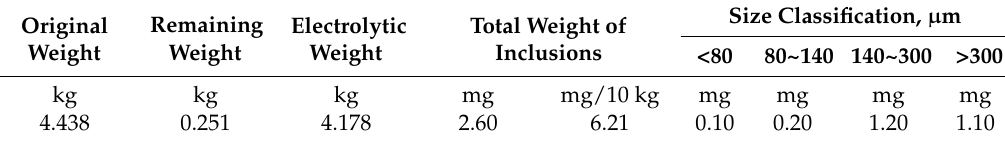
Table 2. Analysis results of large oxide inclusions in steel.